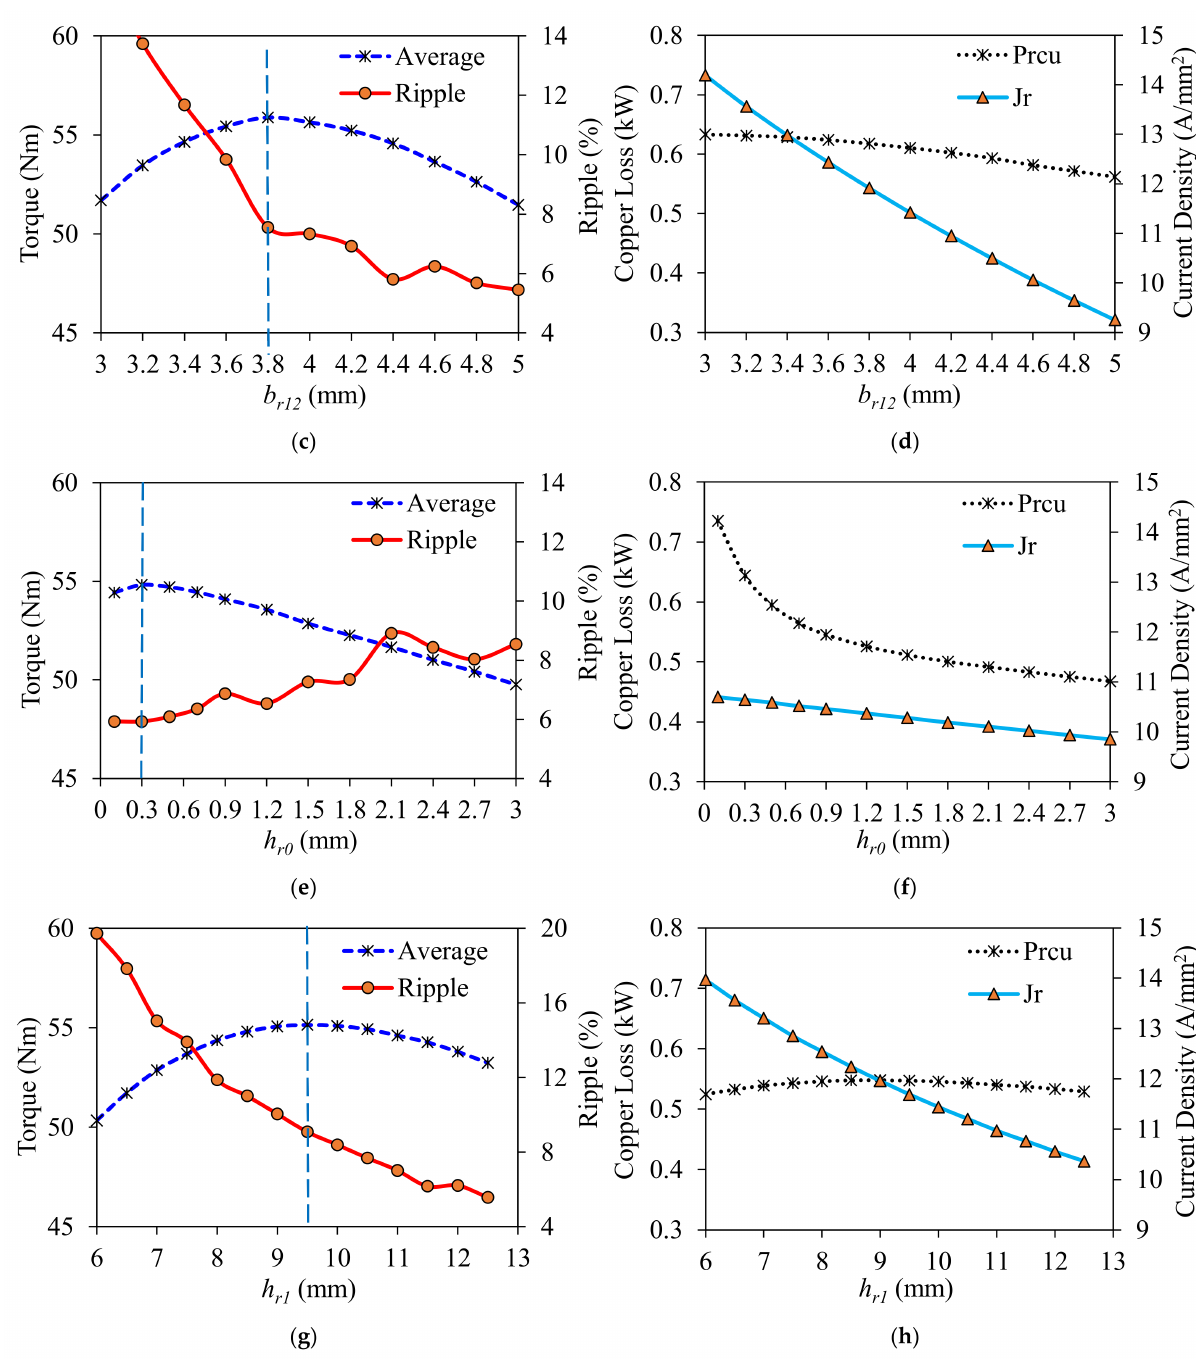
Figure 42. Variation of some key performance characteristics with rotor parameters: ( a ) torque and torque ripple with b r 0 ; ( b ) rotor bar copper loss and current density with b r 0 ; ( c ) torque and torque ripple with b r 12 ; ( d ) rotor bar copper loss and cur-rent density with b r 12 ; ( e ) torque and torque ripple with h r 0 ; ( f ) rotor bar copper loss and current density with h r 0 ; ( g ) torque and torque ripple with h r 1 ; ( h ) rotor bar copper loss and current density with h r 1